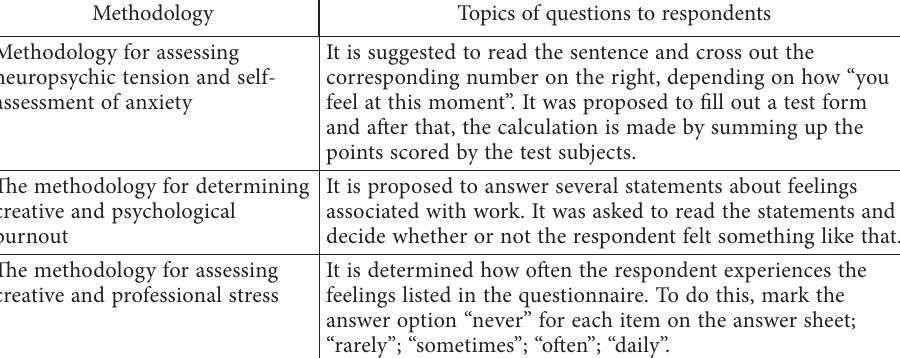
Table 1. Topics of questions that were asked to respondents according to the methods we selected for research (source: created by authors) Methodology Topics of questions to respondents Methodology for assessing neuropsychic tension and